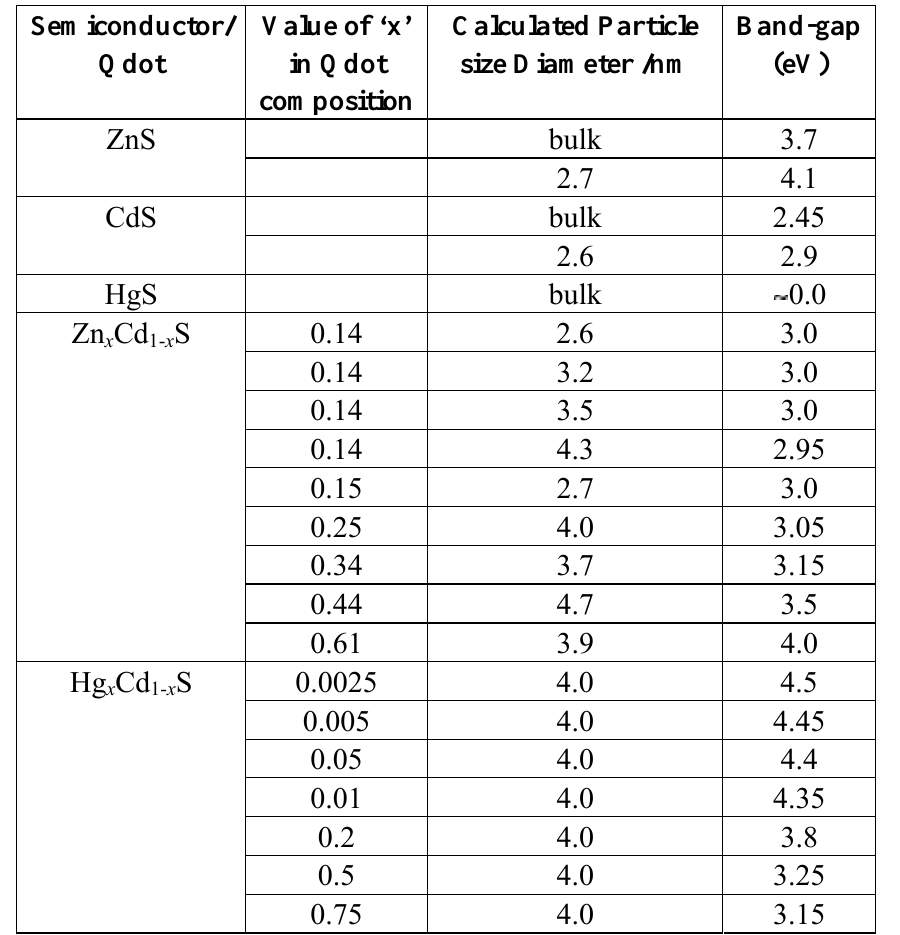
Table 1. Change of band-gaps with composition of Zn Reference